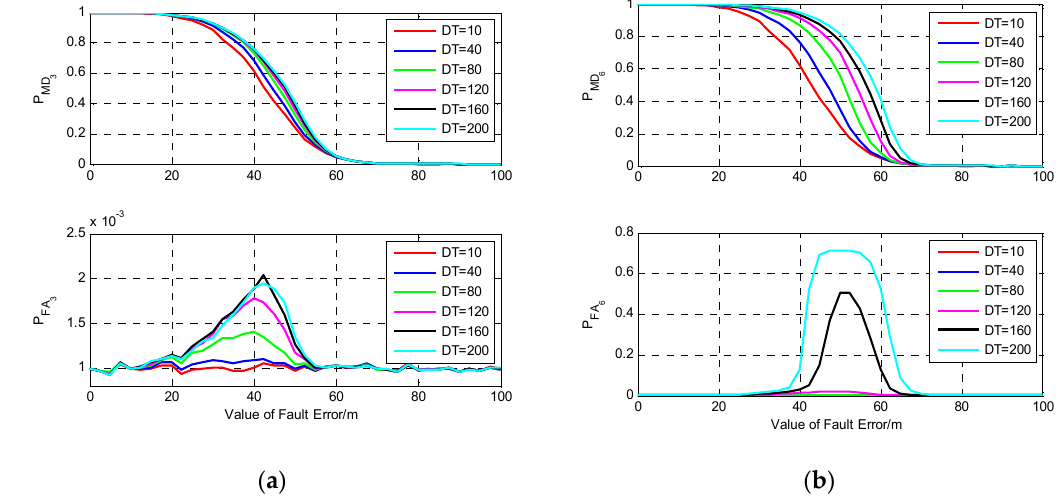
Figure 12. The results of fault detection with six visible satellites. ( a ) Fault occurs on S3; ( b ) Fault occurs on S6.